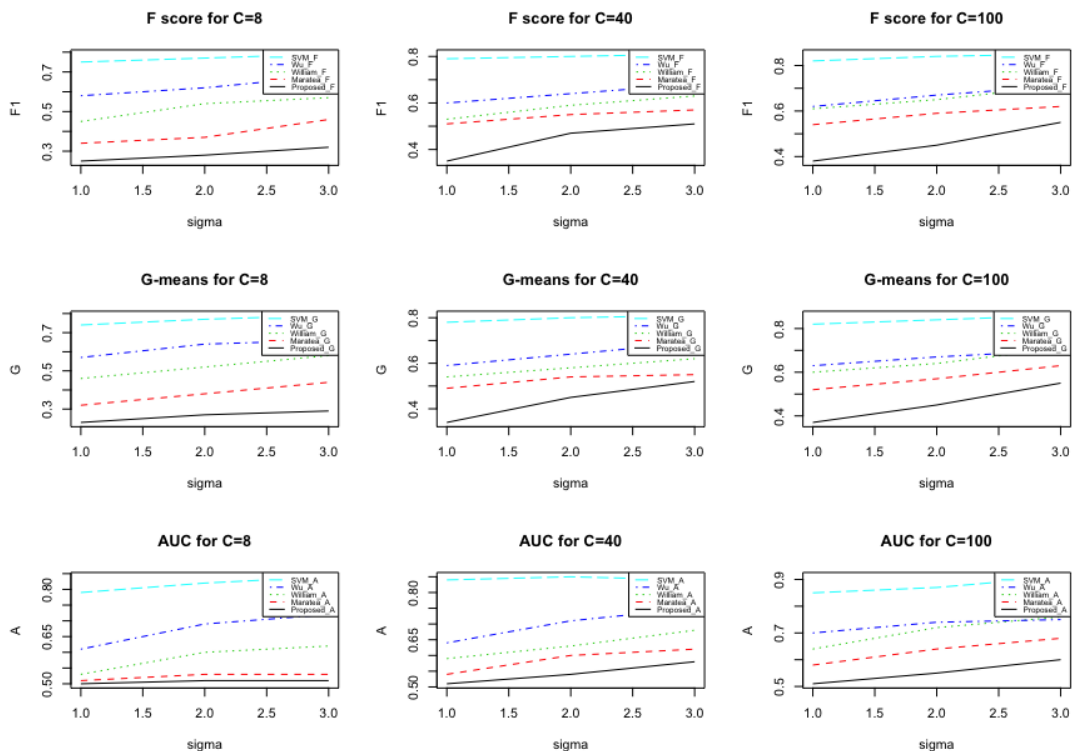
Figure 1. Performance of the competitor methods for Scenario